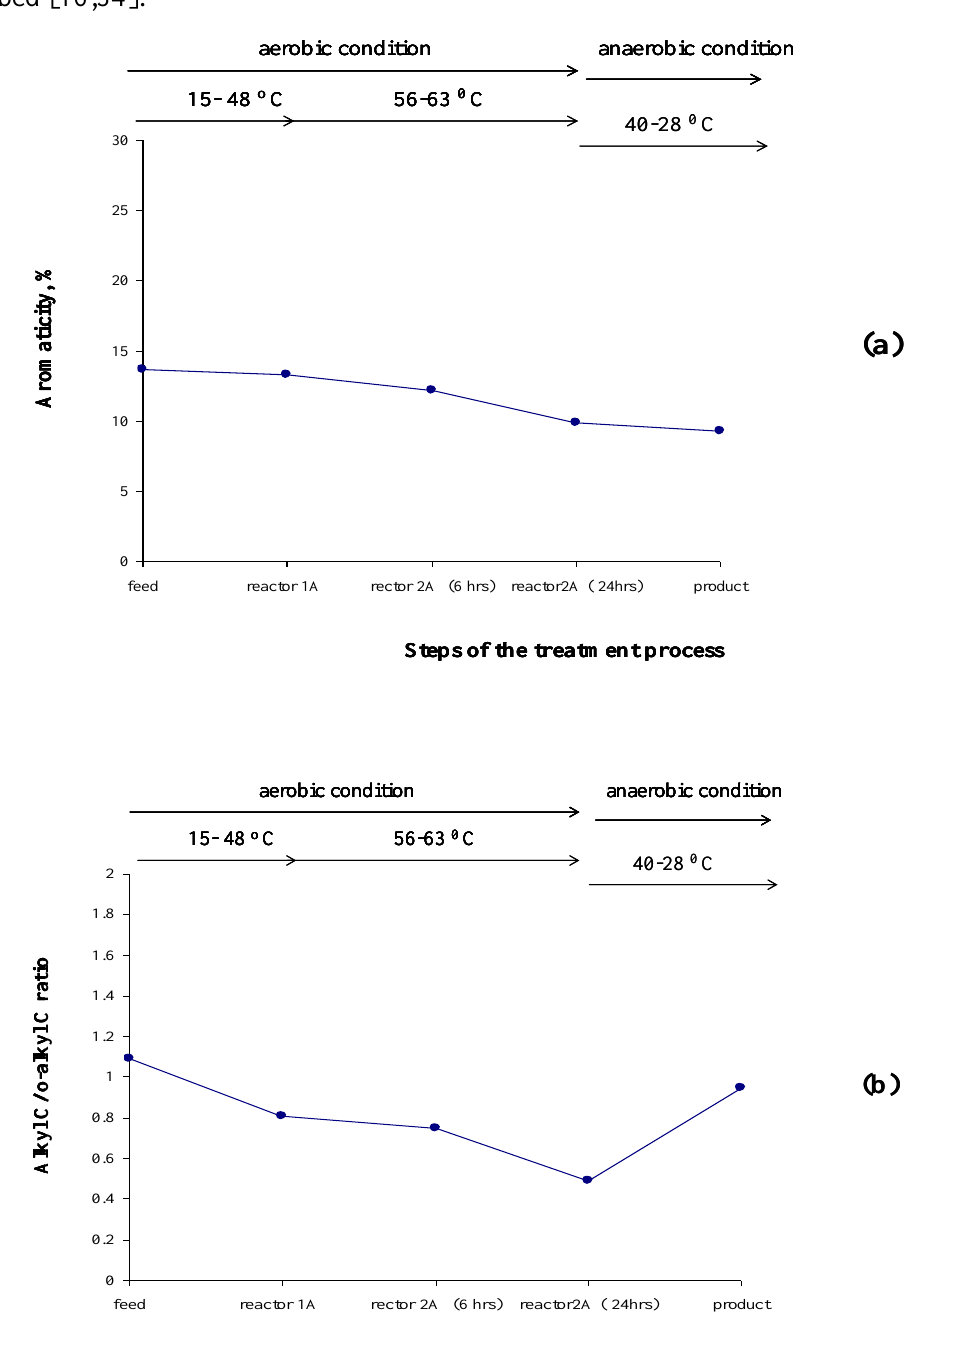
Figure 4. Evolution of the decomposition indexes of the sludge during the ATAD process. (a) Graphical plot of the aromaticity values, (b) ratios of the relative intensities of the carbon domains detected in the alkyl (0-55 ppm) and O-alkyl (55-110 ppm) regions for 13 C-NMR spectra obtained for sludge samples during ATAD processing. The mean value of the data utilized to perform calculations is presented in Table 2. Whole sludge samples were analysed by 13 C-NMR with cross polarizations and magical angle spinning techniques. Operating condition related to oxygen and temperature range during the process steps are shown on the top of the plot. Aromaticity values and Alkyl/O-alkyl ratios was calculated as described